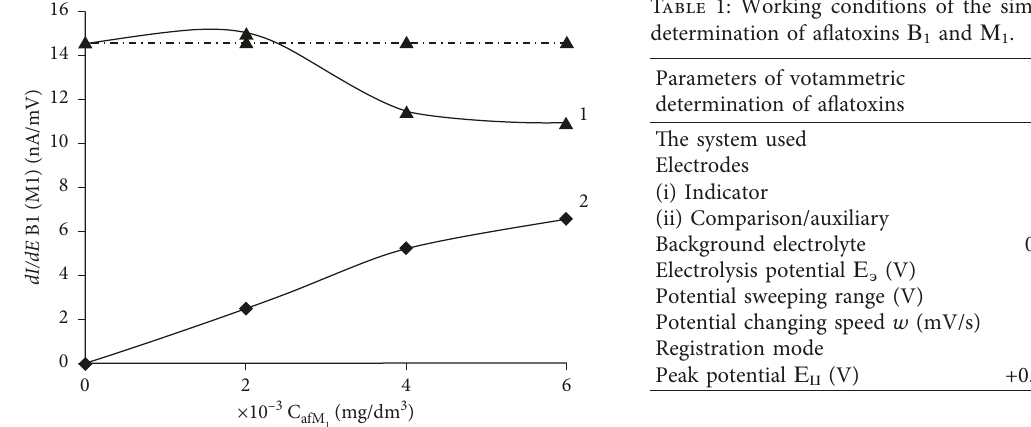
Table 2: Verification of correctness of the voltammetric method for Figure 5: Dependences of the current derivatives of the peak of determination of the content of aflatoxins B 1 and M 1 in model samples aflatoxins C 1 (1) and N 1 (2) on the aflatoxin N 1 content in the ofwhole milkbythe “introduced-found”method ( P � 0 . 95 and n � background electrolyte on the GCE: the background electrolyte is � 2 × 10 − 3 mg/dm 3 and C � var 0.1 N S 6 O 5 P 7 (NH 4 ) 3 ; (1) C afB 1 afM 1